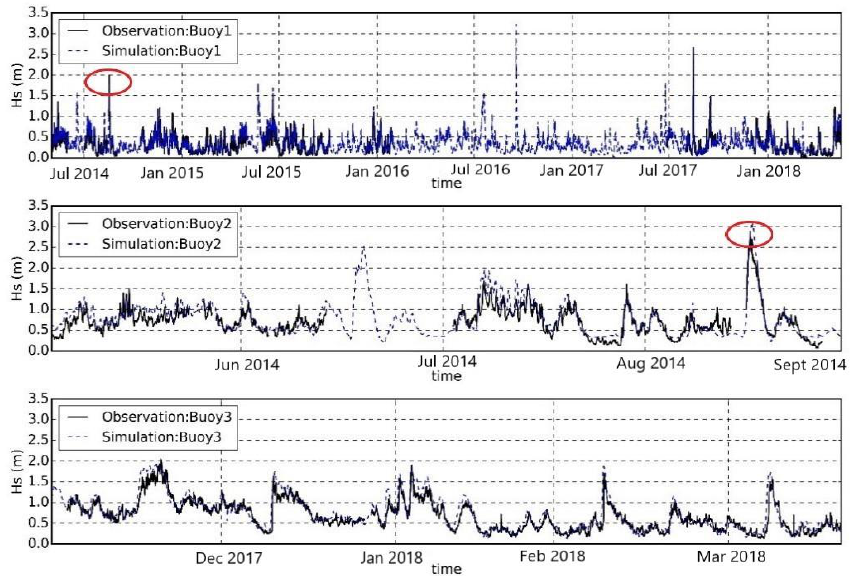
Figure 3. Geographic location of buoy stations in the Xisha Islands.